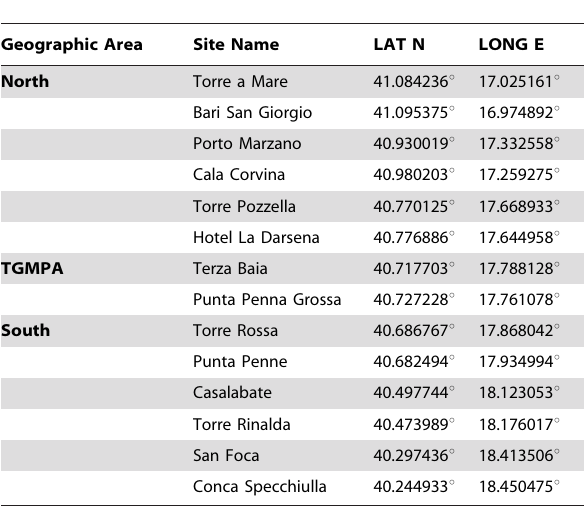
Table 1. Details of sampling sites within each Geographic